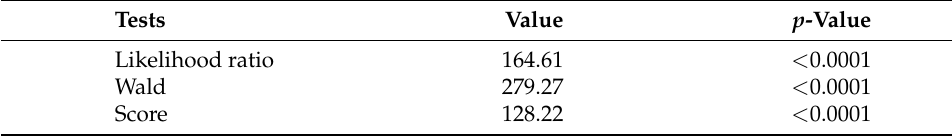
Table 12. Dispersion test for testing H 0 : α =